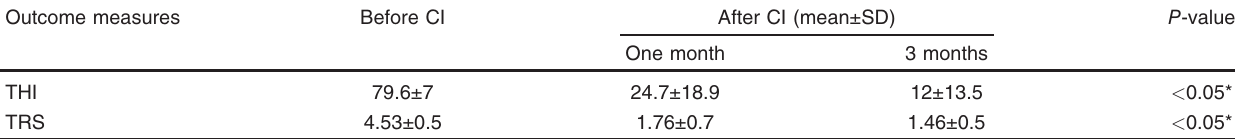
CI, cochlear implantation; THI, Tinnitus Handicap Inventory; TRS, Tinnitus Rating Scale. * P < 0.05, statistically significant (repeated- measures analysis of variance).